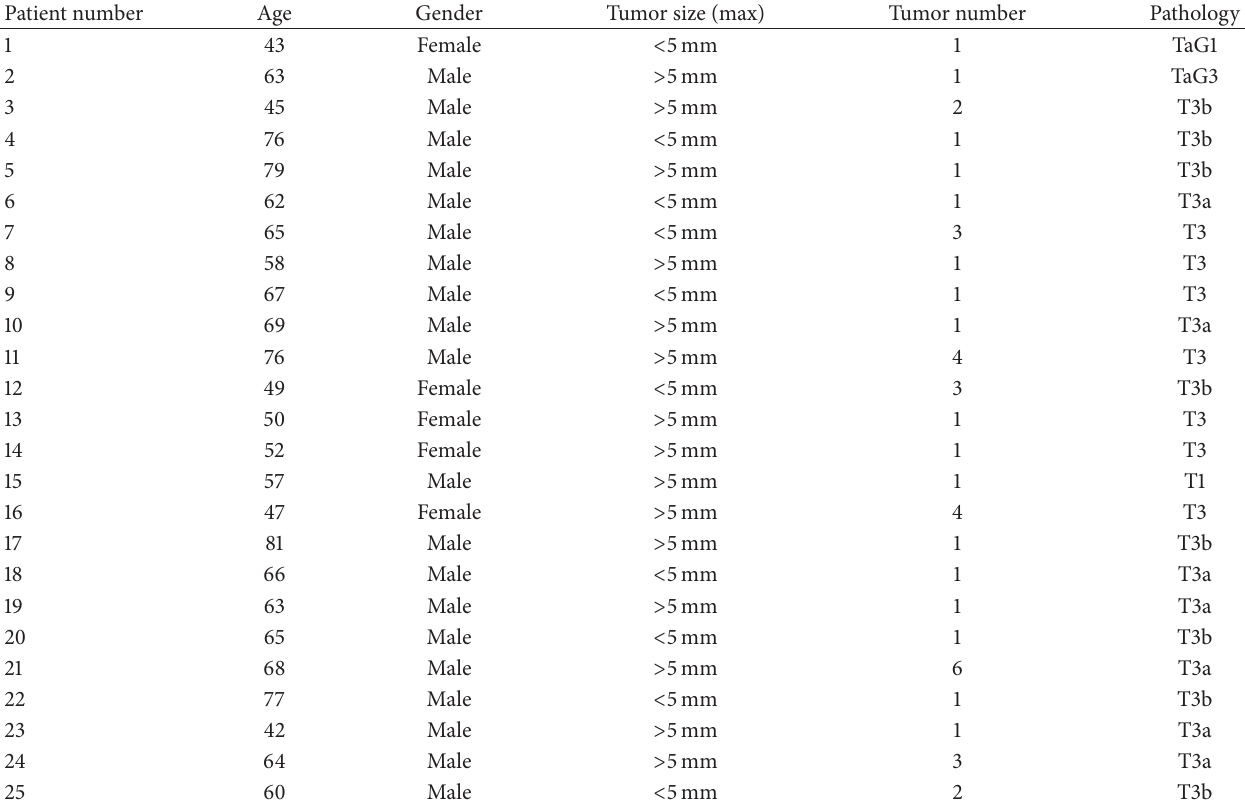
Table 1: The clinical characteristics (age, gender) of the patients as well as the number, size (length of biggest tumor when multiple), and pathology of the tumors